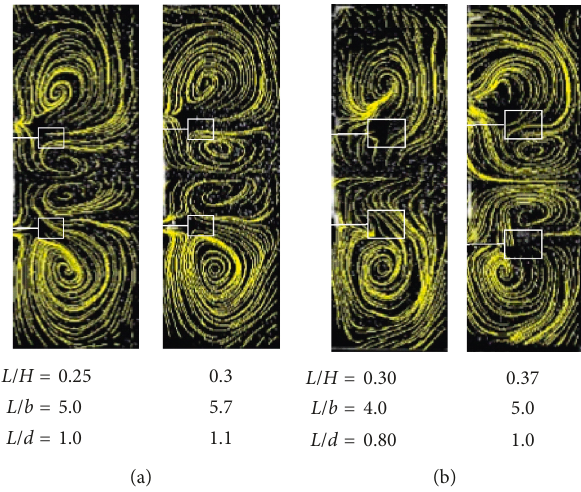
Figure 4: Effect of impeller diameter on flow between impellers at